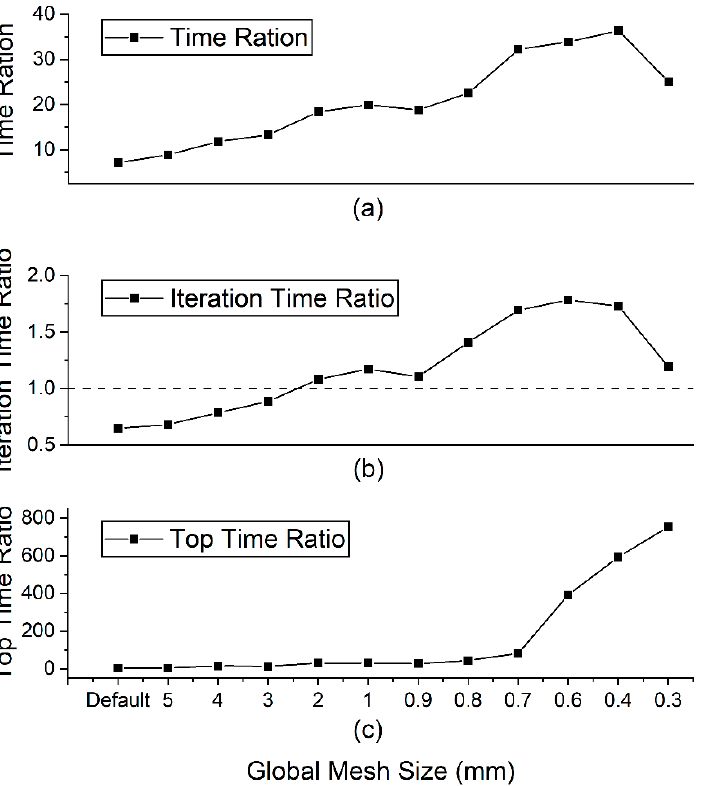
Figure 19. Time ratio. ( a ) Time ratio of two optimization methods under the same mesh size; ( b ) time ratio of average single iterative calculation time of topology optimization to static analysis under the same mesh size; ( c ) comparison of topology optimization under all mesh sizes and static analysis under 3 mm mesh.